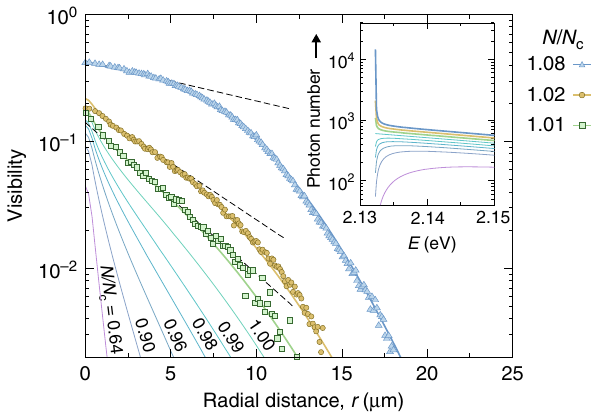
Fig. 5 Correlations near the condensation threshold. First-order correlations ( symbols , see also Fig. 4b) close to the critical photon number of N c = 94000 for three values of N / N c , which have been determined by comparison with numerical calculations ( solid lines ). All three data sets follow closely the expected theoretical behavior. For N / N c = 1.01 ( squares ) and 1.02 ( circles ), we observe a short-range contribution to the correlations as attributed to Gaussian thermal correlations, while between 2 and 6 µ m the correlations reveal an exponential decay resulting from quantum degeneracy of low-energy states (see inset). For radii beyond the oscillator length σ 0 = 7.7 µ m, correlations decay due to the fi nite condensate width, as visible in the data for N / N c = 1.08 ( triangles ). Exponential fi ts ( dashed lines ) to the data yield correlation lengths ξ = {7.4(2); 9.6(5); 21.6(29)} μ m for N / N c = {1.01; 1.02; 1.08}. For the uncondensed phase ( N / N c < 1), where data acquisition is prohibited by insuf fi cient SNR of the imaging system, we show numerical calculations to illustrate the behavior of the photon gas correlations ( solid lines ). Inset: Theory spectra of the photon distribution (vertically shifted) for corresponding values of N / N c show the balanced population of the lowest-energy modes near the condensation